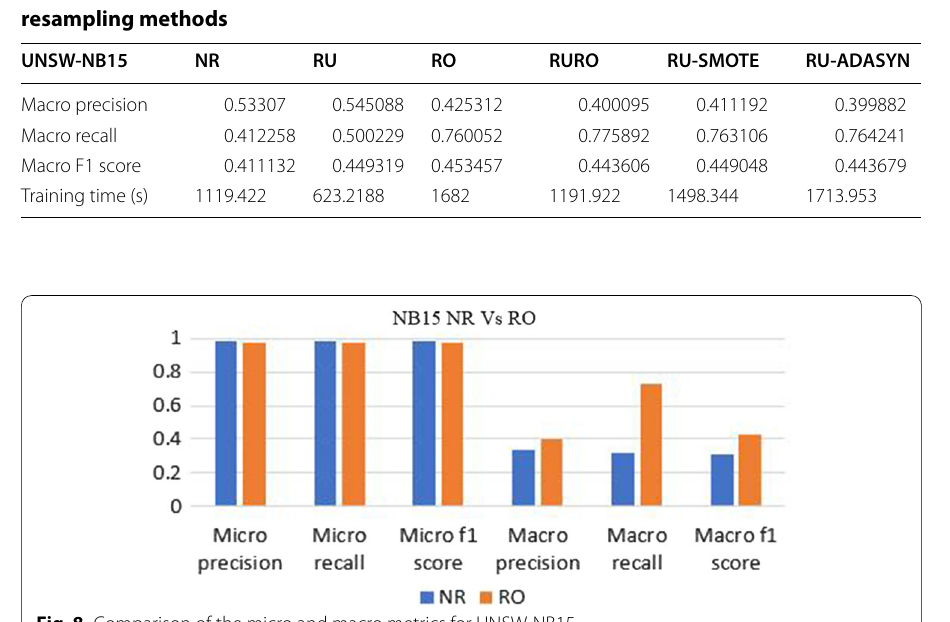
Fig. 8 Comparison of the micro and macro metrics for UNSW-NB15